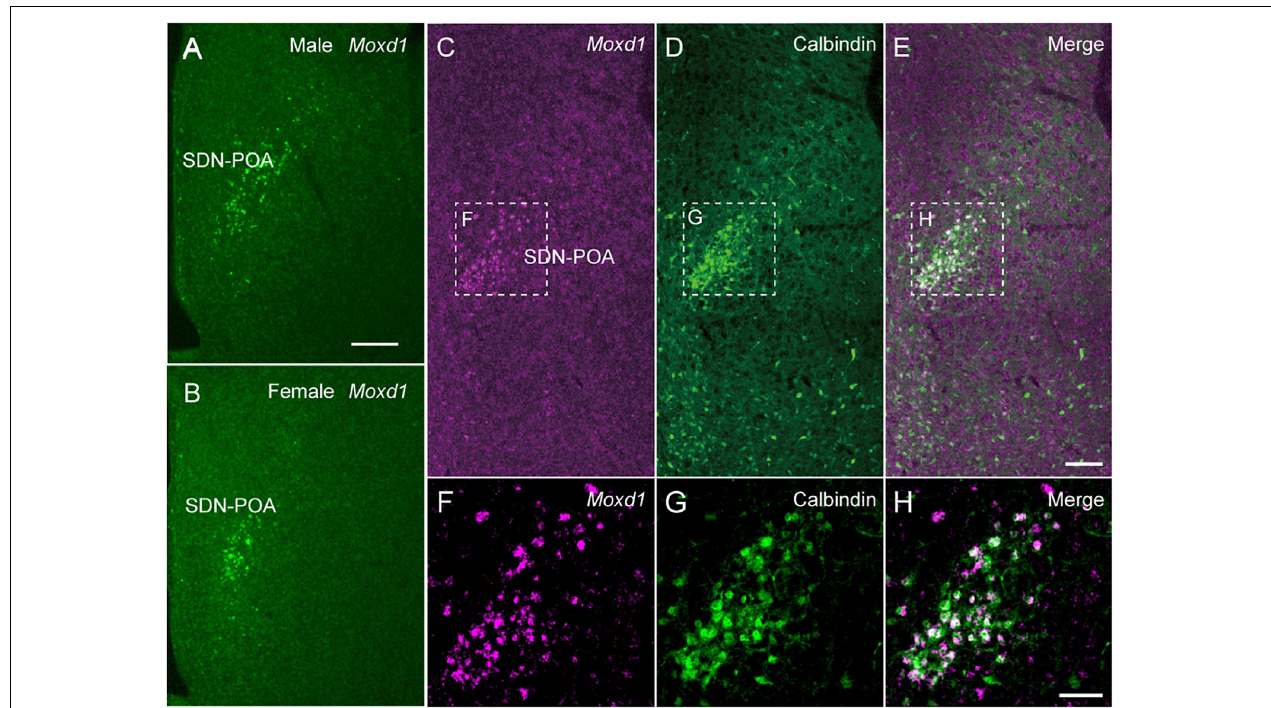
FIGURE 4 | Moxd1 mRNA as a marker for sexually dimorphic nucleus. (A,B) Moxd1 mRNA expression in the sexually dimorphic nucleus of the POA (SDN-POA) of (A) male and (B) female mice. The number of Moxd1 -positive cells of the SDN-POA are higher in males than in females. (C,D) The SDN-POA has cells expressing (C) Moxd1 and (D) calbindin. (E) Merged images of Moxd1 and Calbindin. (F,G) Moxd1 , calbindin, merged image of dashed rectangles in panels (C–E) . Scale bars: (A) 200 µ m, (E) 100 µ m, and (H) 50 µ m. Modified from Tsuneoka et al.